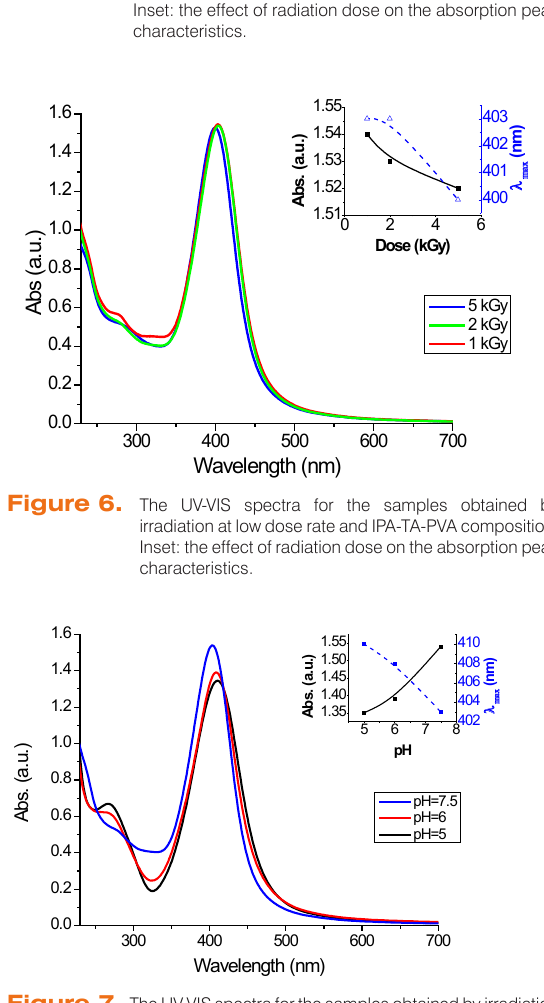
Figure 7. The UV-VIS spectra for the samples obtained by irradiation at low dose rate and different pH values, irradiation dose 2 kGy. Composition type IPA-TA-PVA. Inset: the effect of pH on the absorption peak